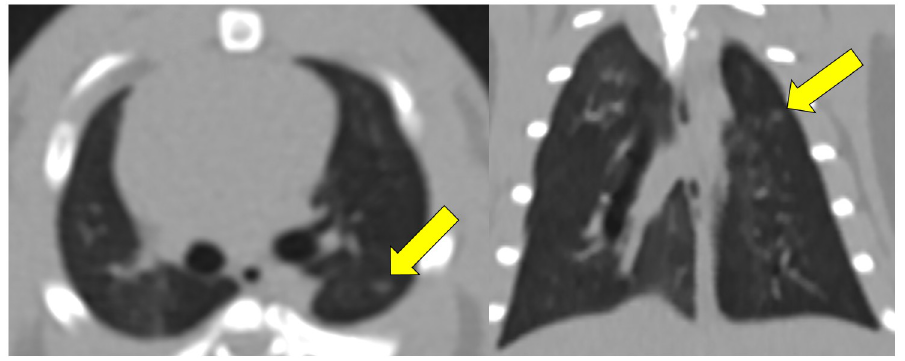
Fig 5. Chest CT images with axial and coronal reconstruction of adenocarcinoma from rat #2 show a nodule in the left upper region (arrow).